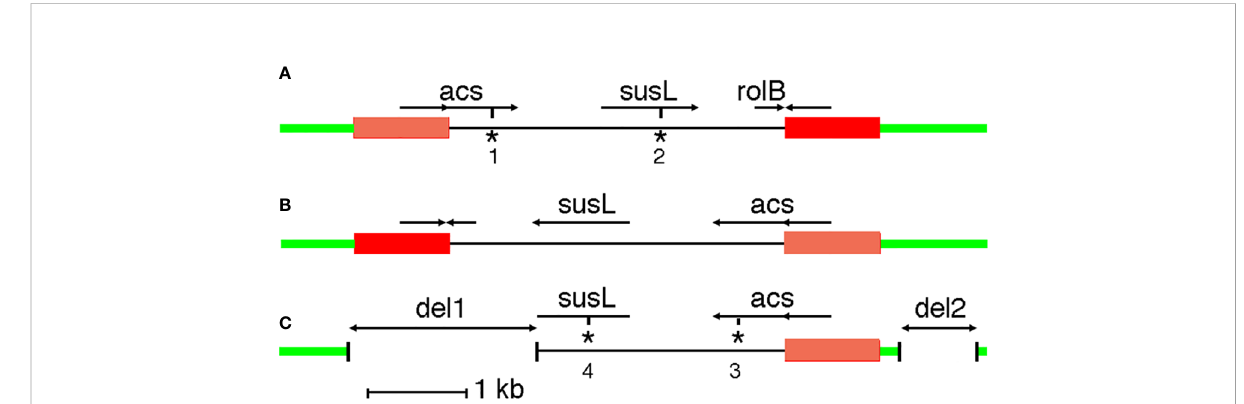
FIGURE 1 CaTA maps. (A) CaTA map common to all accessions, except C. fangchengensis . (B) First putative step in origin of C. fangchengensis CaTA. Inversion of the central part. (C) Second putative step in origin of C. fangchengensis CaTA: two deletions (del1 and del2). The plant DNA surrounding the CaTA insert is marked in green, the CaTA inverted repeats are marked in orange (left repeat) and red (right repeat). acs : agrocinopine synthase gene, susL : L,L-succinamopine synthase gene, rolB : root locus B gene. *1: stop codon at 1556, *2: 32 nt deletion at 3182 and frameshift, *3: stop codon at 1538, *4: 1 nt deletion at 3147 and